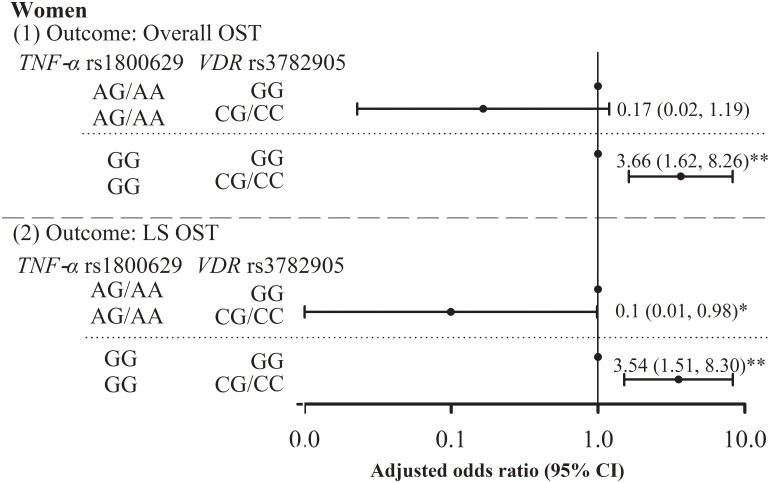
Stratified analysis by TNF-α rs1800629 for significant interaction of VDR rs3782905 with TNF-α rs1800629 on overall OST (1) and LS OST (2) among women is shown.The adjusted ORs were obtained from the model with consideration of SNP, age, BMI, physical activity, smoking, and drinking. *p < 0.05. OST: osteoporosis; LS: lumbar spine.